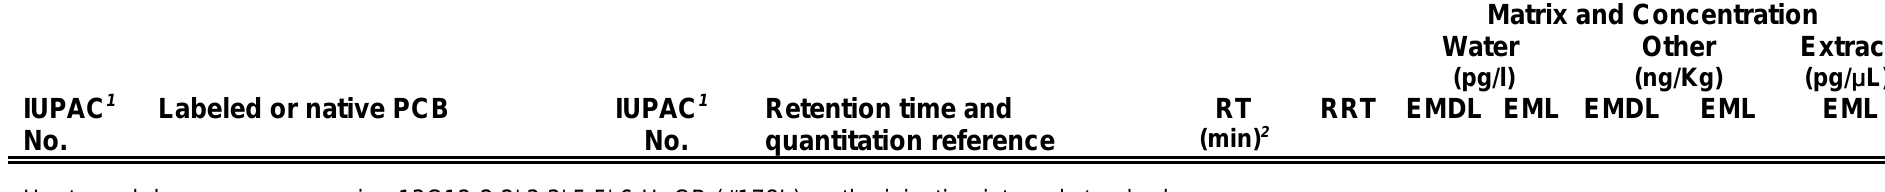
Table 2. (cont.) Retention Time (RT) References, Quantitation References, Relative Retention Times (RRTs), Estimated Method Detection Limits (EMDLs), and Estimated Minimum Levels (EMLs) for the Toxic PCBs